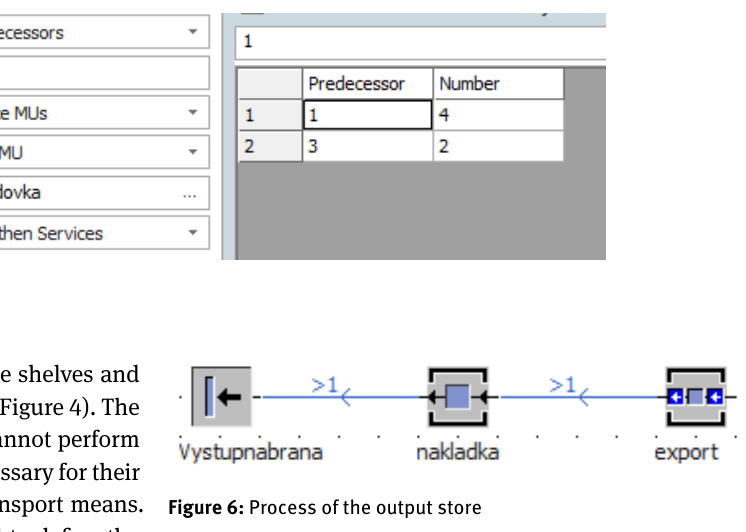
Figure 6: Process of the output